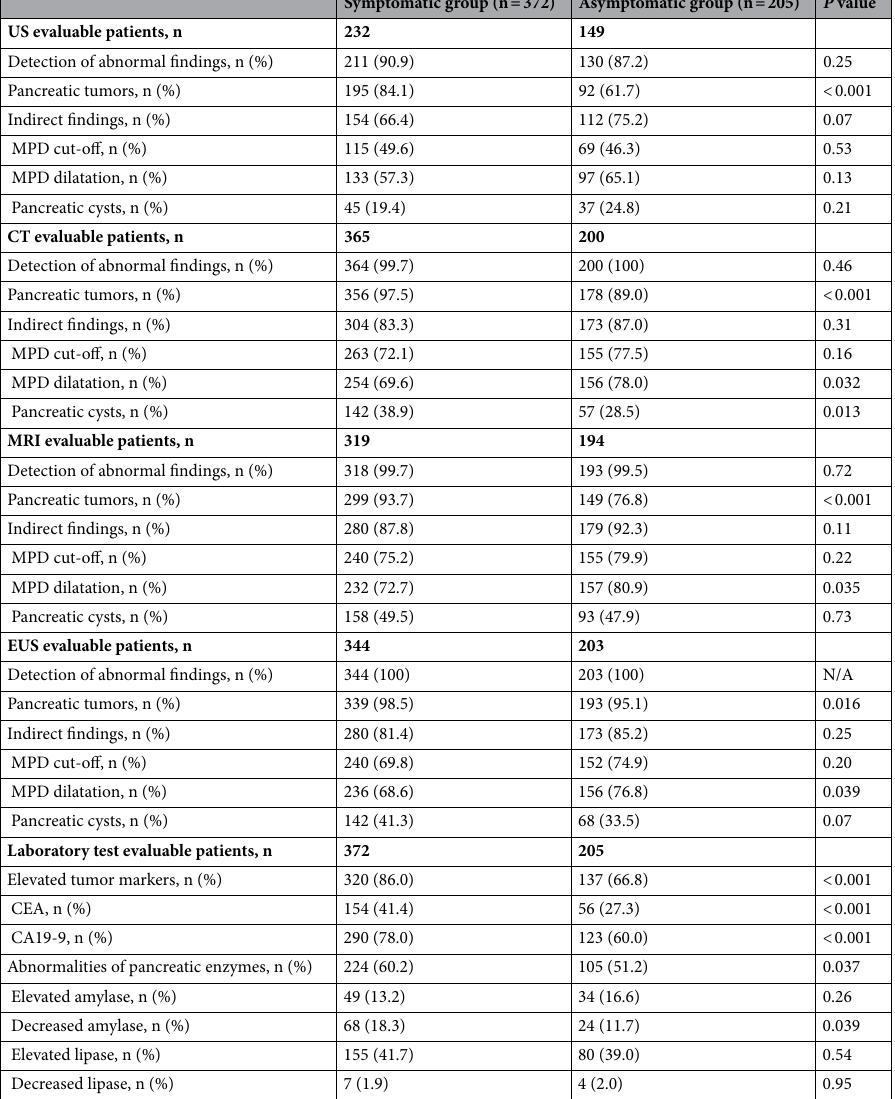
Table 6. Comparison of imaging and laboratory test results between symptomatic and asymptomatic patients. US ultrasonography, CT computed tomography, MRI magnetic resonance imaging, EUS